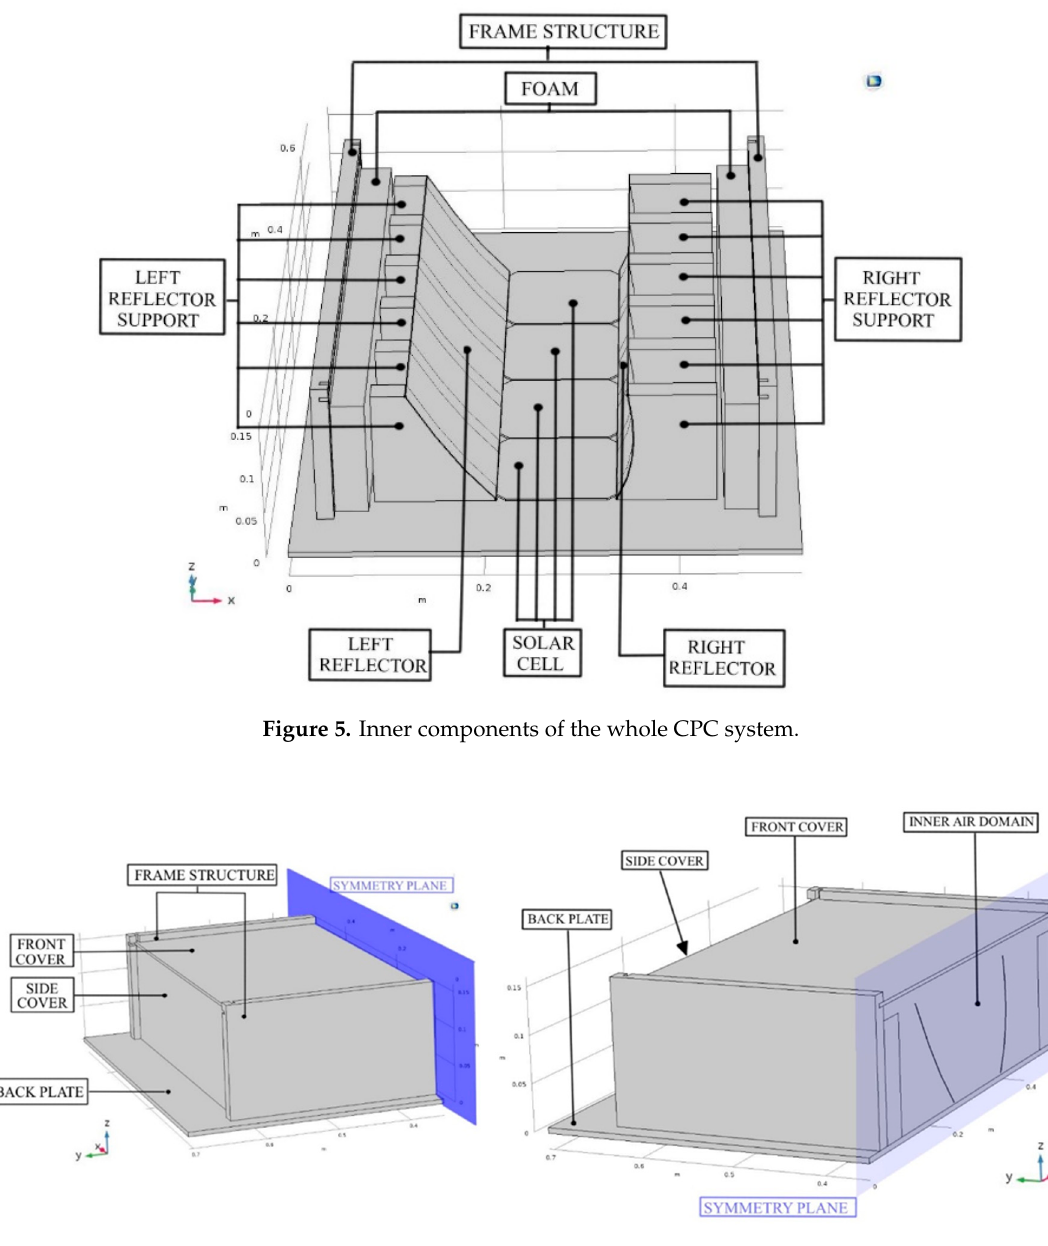
Figure 6. External components of a covered CPC system symmetry model: ( a ) back view; ( b ) symmetry plane view.